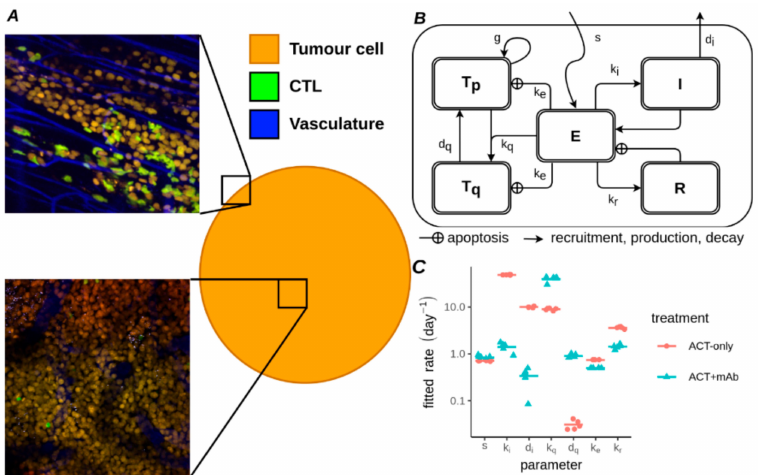
Figure 3. ODE model linking intravital and volumetric measurements from ACT treated tumours. ( A ) Examples of imaged positions with varying numbers of tumour cells, shown with their presumed location inside the tumour (circle). ( B ) Schematic of ODE model. ( C ) Best fitting parameters for the ODE model. Each point represents 1 of 5 fits using the stochastic evolutionary algorithm. Horizontal lines represent the mean fitted parameter for either ACT-only (red) or ACT+mAb (blue)